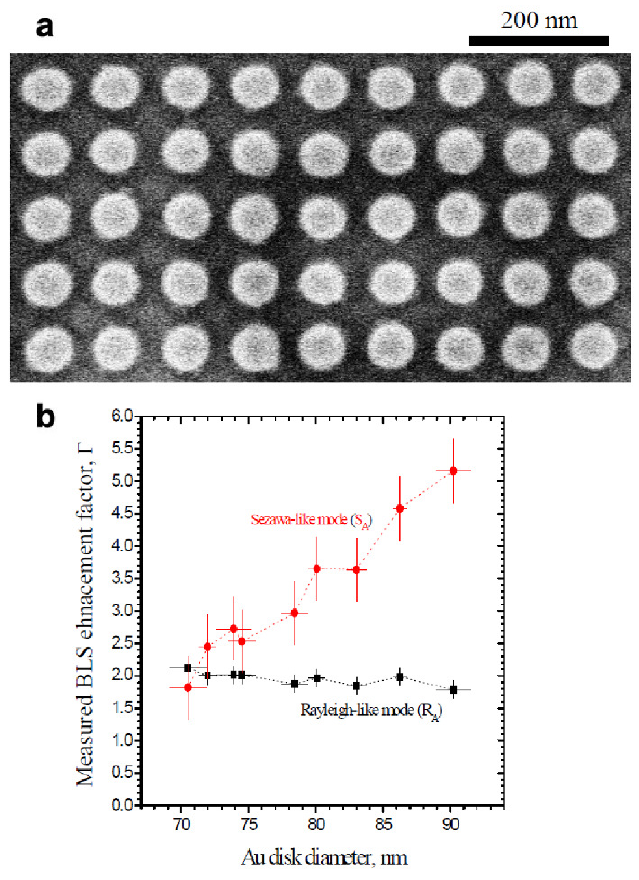
Figure 9. ( a ) Image of a section of a gold nanodisc array on glass; ( b ) Acoustic BLS enhancement factor Γ the Rayleigh-like and Sezawa-like modes as a function of the nanodisc diameter. Reproduced with permission from